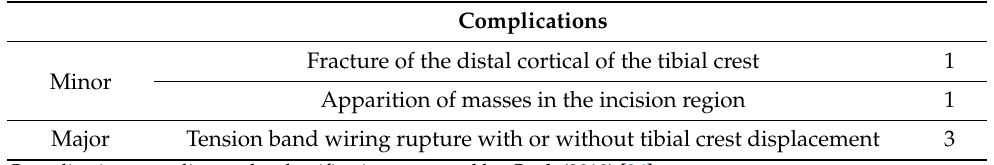
Table 5. Complications. Complications Fracture of the distal cortical of the tibial crest 1 Minor Apparition of masses in the incision region 1 Major Tension band wiring rupture with or without tibial crest displacement 3 Complication attending to the classification proposed by Cook (2010)